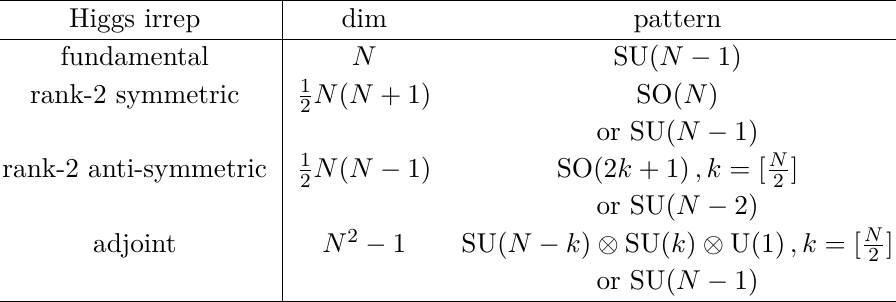
Table 1 . The Higgs representations and the corresponding symmetry breaking patterns in the SU( N )